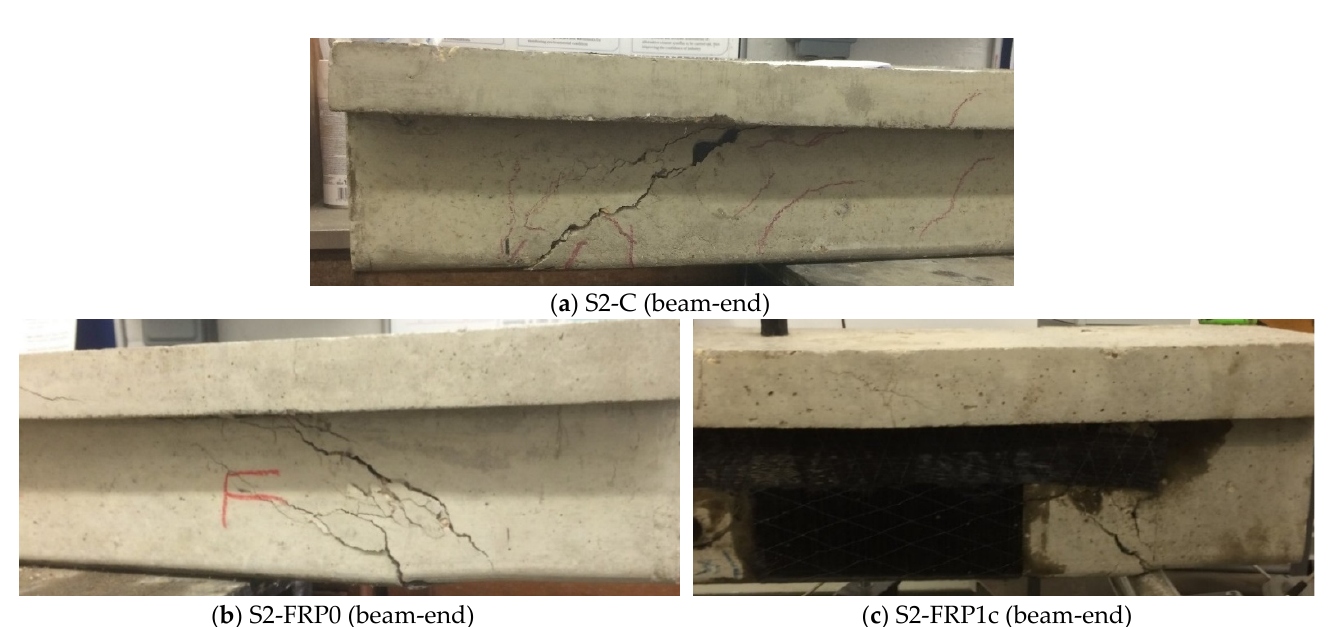
Figure 7. Observed failure in beams of series 2—( a ) S2-C, ( b ) S2-FRP0 and ( c ) S2-FRP1c.